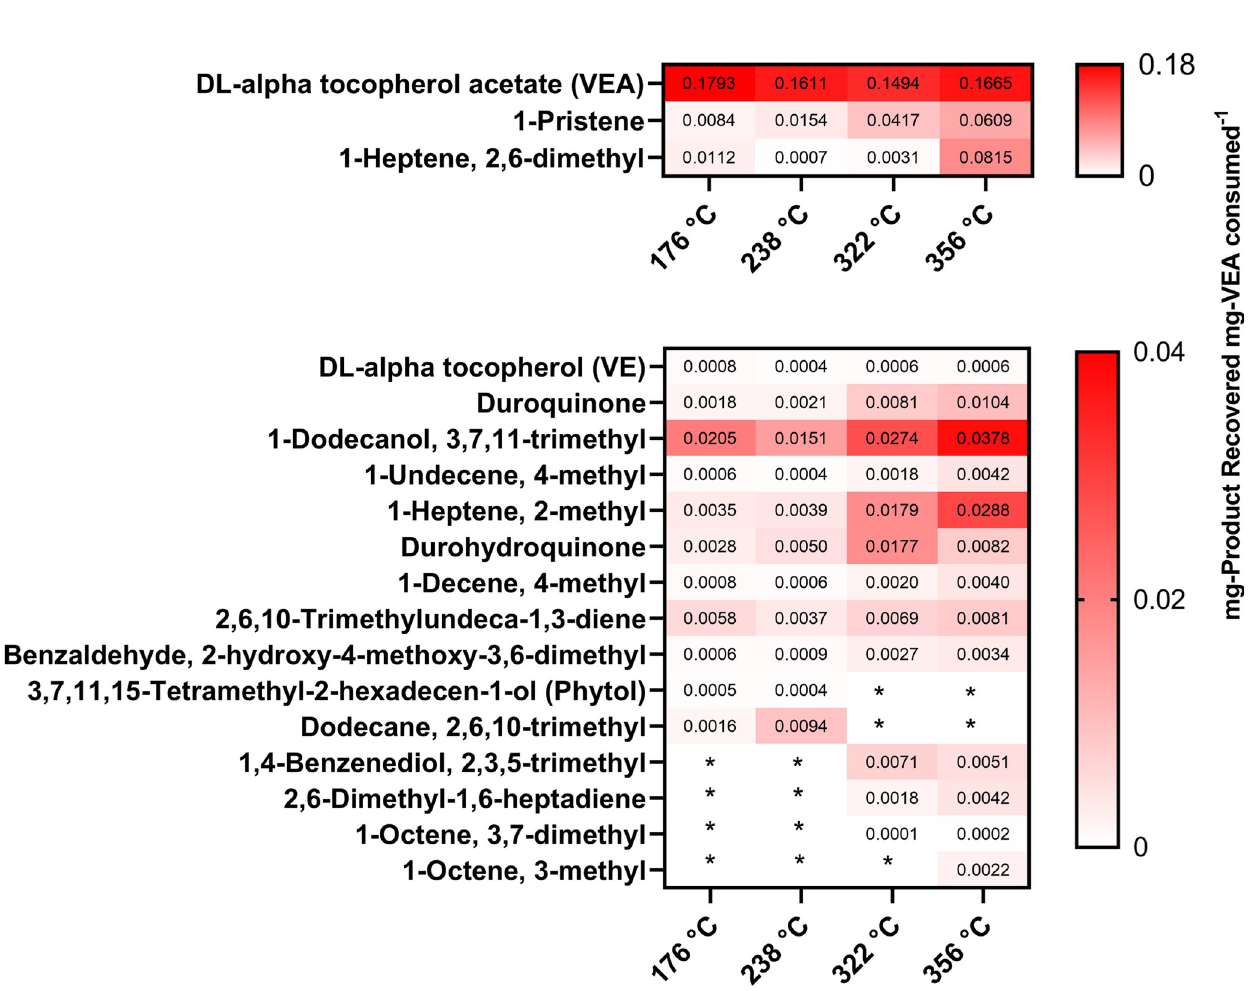
Fig 4. Heatmap of VEA vaping emission product distribution at 176, 237, 322, and 356˚C. Compounds were identified via NIST mass spectral library and included based on frequency and consistency of detection throughout all collections. Asterix indicates that the concentration of a product was below the detection limit of the instrument.